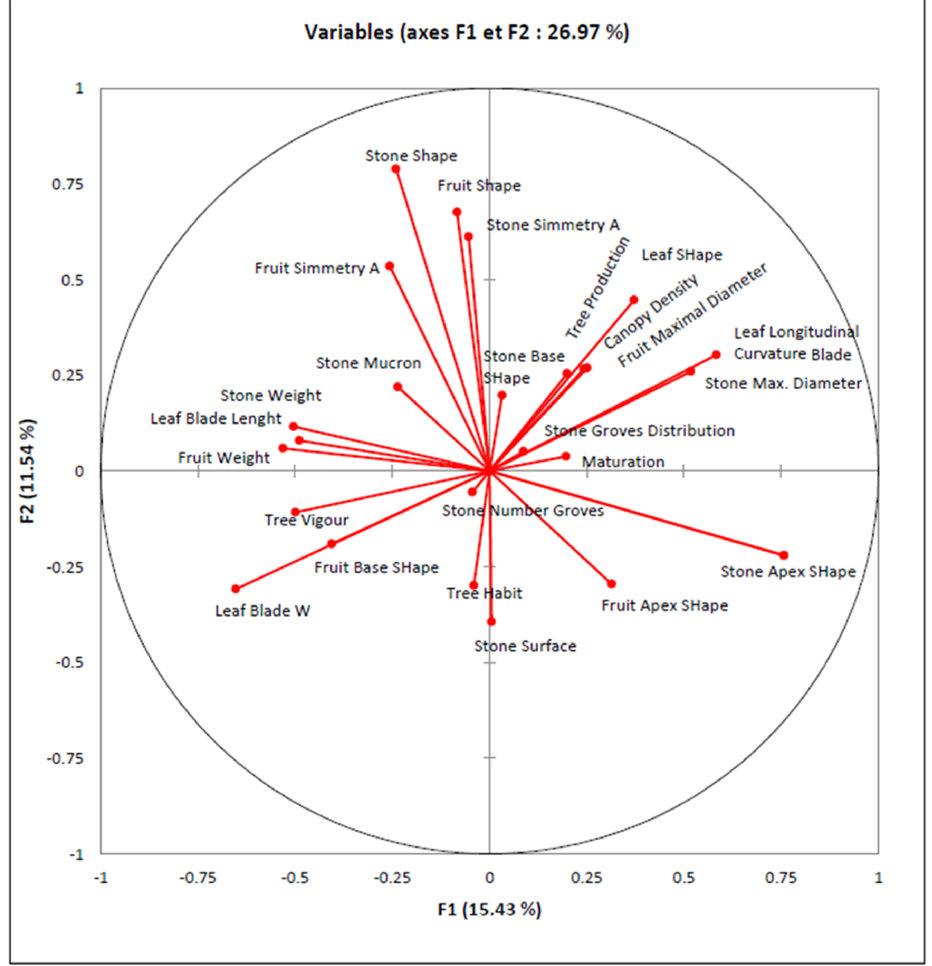
Figure 4. Plot illustrating the relationships among the 25 polymorphic qualitative morphological traits assessed via PCA analysis of 175 wild olive trees (Nipple, Lenticels, and Dimension Lenticels were excluded because they showed to be monomorphic among samples).